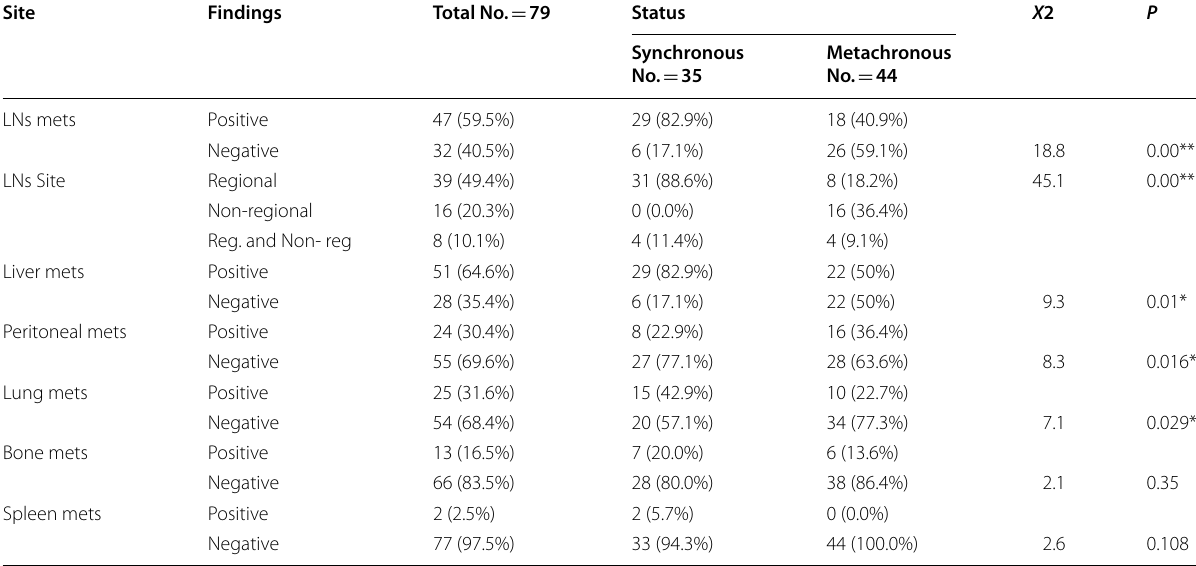
Table 2 Distribution of metastatic sites among studied group